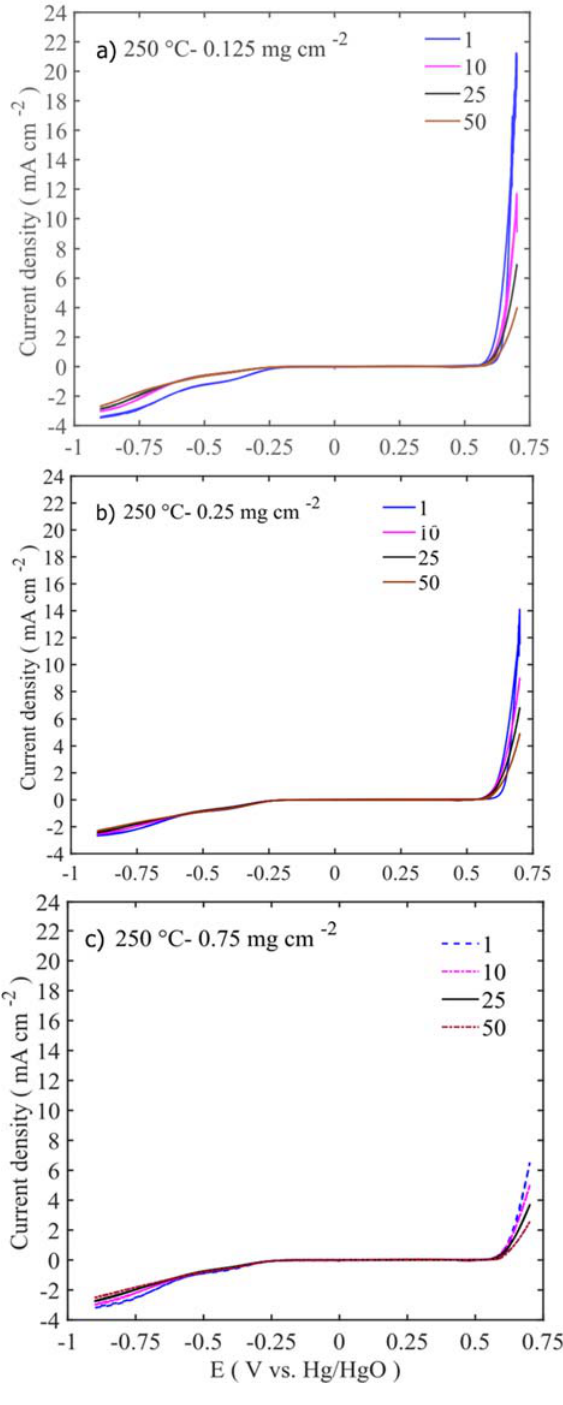
Figure 10. Electrochemical stability of Ni Fe oxide at 250 °C calcined sample with three different mass loadings ( a ) 0.125, ( b ) 0.25, and ( c ) 0.75 mg cm − 2 .